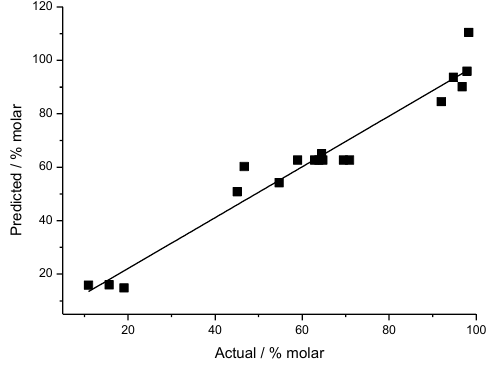
Figure 5. Predicted versus actual values for C2 = experimental response. Table 2. Analysis of variance for the BTEX experimental response.